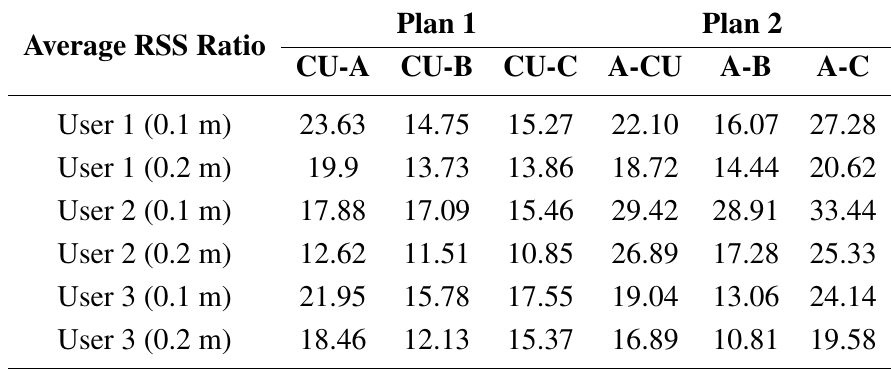
Table 4. Part results of Plans 1 and 2. Distance in parentheses means how far the sender is to the user.